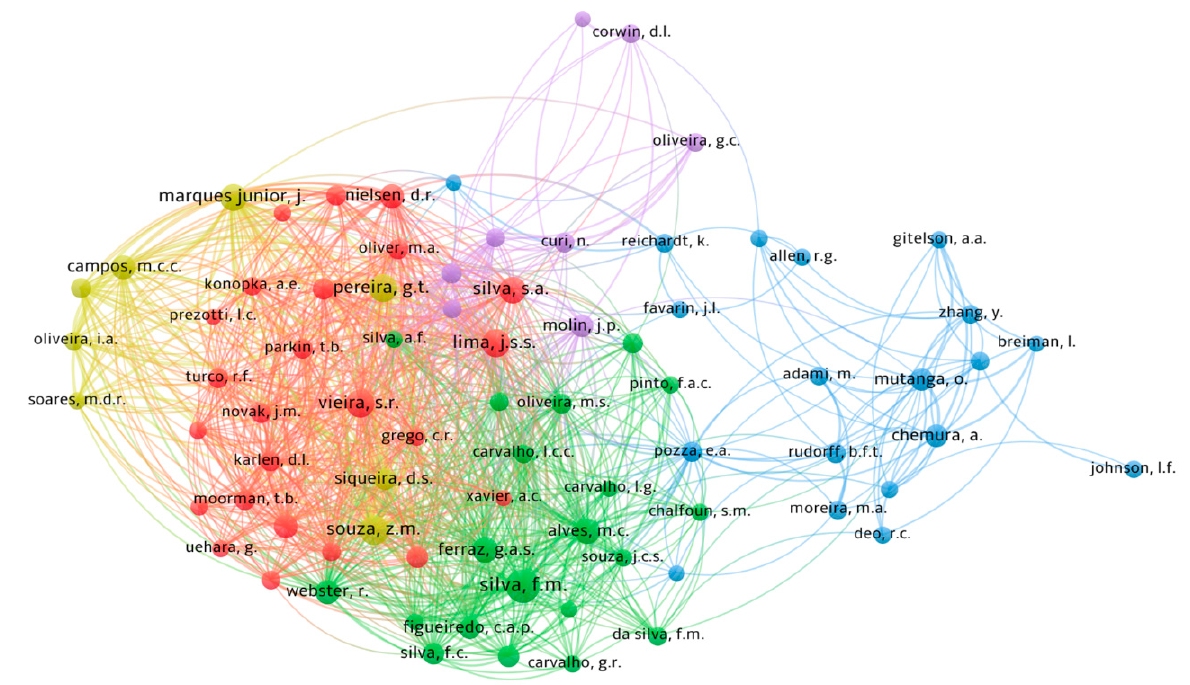
Figure 3. Scientific mapping of the cocitation of authors most relevance in precision coffee growing research. Red and yellow: Solo. Green: variable rate application and productivity mapping. Blue: remote sensing and Purple: plant nutri- tional status.